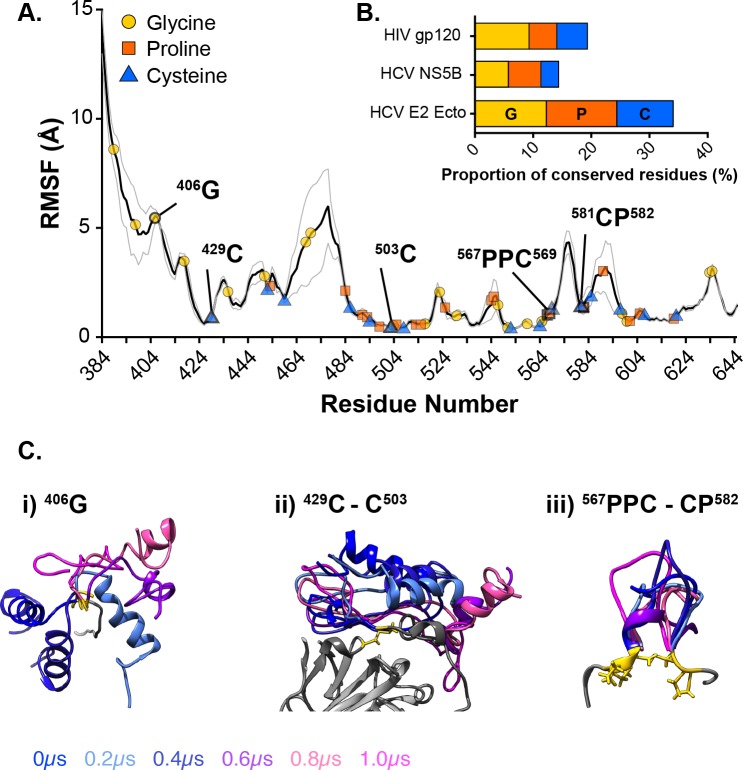
Highly conserved residues act as hinges and tethers to articulate E2.Comparison of E2 sequence data and RMSF profile reveal highly conserved residues that sit at transitions in protein flexibility. A. Average E2 RMSF—calculated by combining data from H77, 1b09 and J6—annotated with conserved glycines, prolines and cysteines. Specific example residues are highlighted. The grey line indicates standard error of the mean. B. The proportion of conserved residues that are either glycine, proline or cysteine in HIV gp120 (a viral glycoprotein), HCV NS5B (an RNA-dependent polymerase) or HCV E2 ectodomain. E2 exhibits an enrichment for these amino acids. C. Specific examples of hinge or tether points in E2 from a single representative H77 E2 trajectory, 200ns snapshots are shown. i) HVR-1 rotates around G406. ii) The C429-C503 disulphide bond anchors the N-terminus of E2 to the β-Sandwich. iii) Conserved proline and cysteine residues loop and isolate VR-3 from the core of E2. In each case, the region of interest is color-coded by time and the conserved residues highlighted in gold; to provide context, other selected elements of E2 are shown in grey for the T = 0μs snapshot alone. In each case, structures were aligned using reference residues surrounding the stated feature.